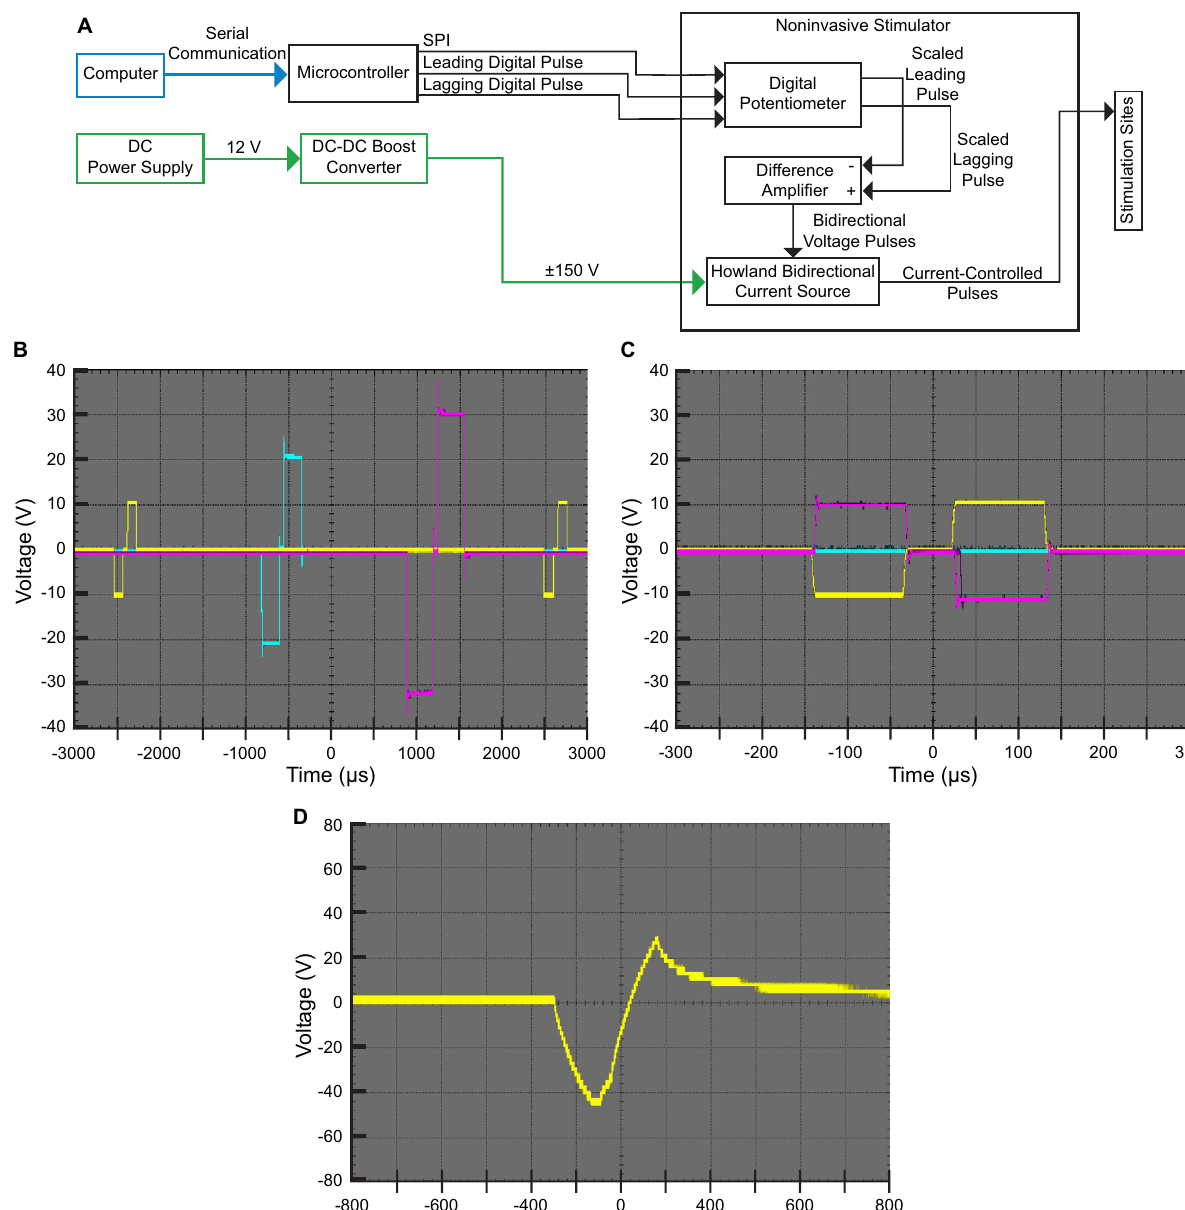
Figure 2. ( A ) The stimulator can consist of three stimulator boards stacked on top of an Arduino Uno microcontroller. The stimulus is defined by commands written via serial communication. The digital pulses are scaled by the digital potentiometer which is controlled via SPI. A differential amplifier inverts one of the pulses and combines it with the positive pulse. The voltage pulses are the input to the Howland, bidirectional current source. The Howland current source is powered by a DC-DC boost converter that is in turn powered by a 12-V power source. ( B ) The stimulator produces a series of interleaved biphasic pulses of varying amplitudes, driving current between that channel and a common ground electrode. The yellow line represents channel one, the blue line represents channel two, and the pink line represents channel three. Vertical gradations indicate 10 V and the horizontal gradations indicate 500 µs. ( C ) The stimulator can also produce bipolar stimulation across multiple channels. One channel provides a cathodic pulse while another channel provides an anodic pulse simultaneously. Vertical gradations indicate 10 V and the horizontal gradations indicate 50 µs. The overshoot seen in some of the waveforms is common to this Howland current source design. The charge associated the short overshoot is negligible. The trapezoidal shape of the square waves is cause by the slew rate of the op-amps used in the design. However, this linear region is small enough to not effect operation. ( D ) The noninvasive stimulator delivering a 3-mA 300-µs cathodic-first biphasic waveform with a 50-µs interphase interval through the skin via adhesive gel electrodes. The voltage across the electrodes was measured using an oscilloscope. Vertical gradations indicate 20 V and the horizontal gradations indicate 200 µs. A compliance voltage of approximately 46 V is observed when driving 3 mA. Higher compliance voltages (up to 150 V) are necessary to drive higher currents through the